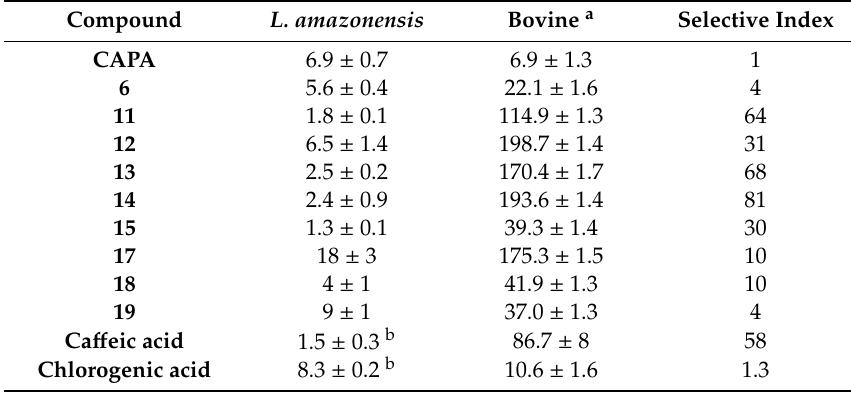
Table 2. Comparison of IC 50 inhibition of Leishmania and bovine